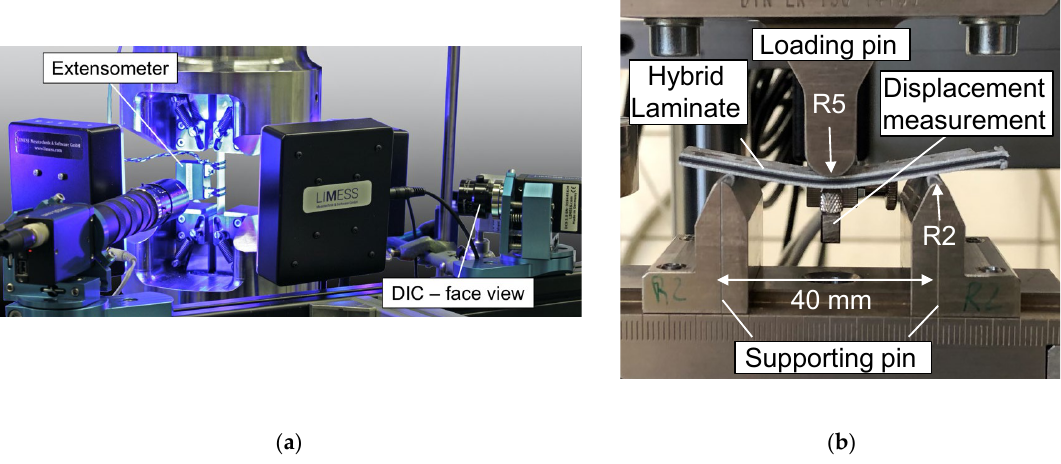
Figure 4. ( a ) Instrumented tensile and fatigue testing setup containing the servo-hydraulic testing system, digital image correlation camera perpendicular to the specimen (face view), and tactile extensometer; ( b ) Three-point bending testing setup according DIN EN ISO 14125.